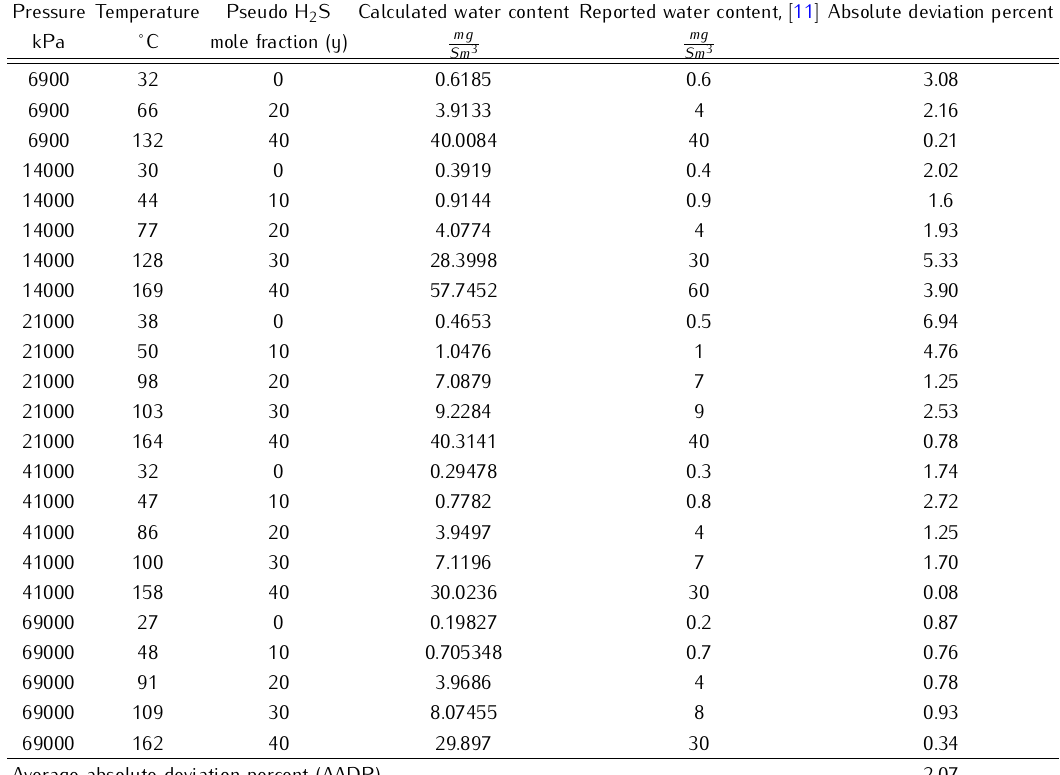
Table 3. Comparison of obtained results of new proposed predictive tool for predicting water content of sour gases with the reported data [11]. Pressure Temperature Pseudo H 2 S